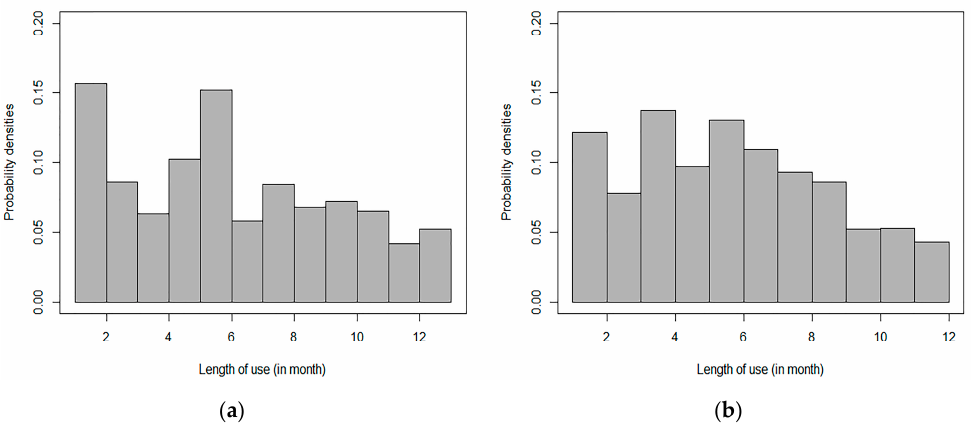
Figure 4. ( a ): Distribution of the length of use in the first stage (in months). ( b ): Distribution of the length of use in the second stage (in